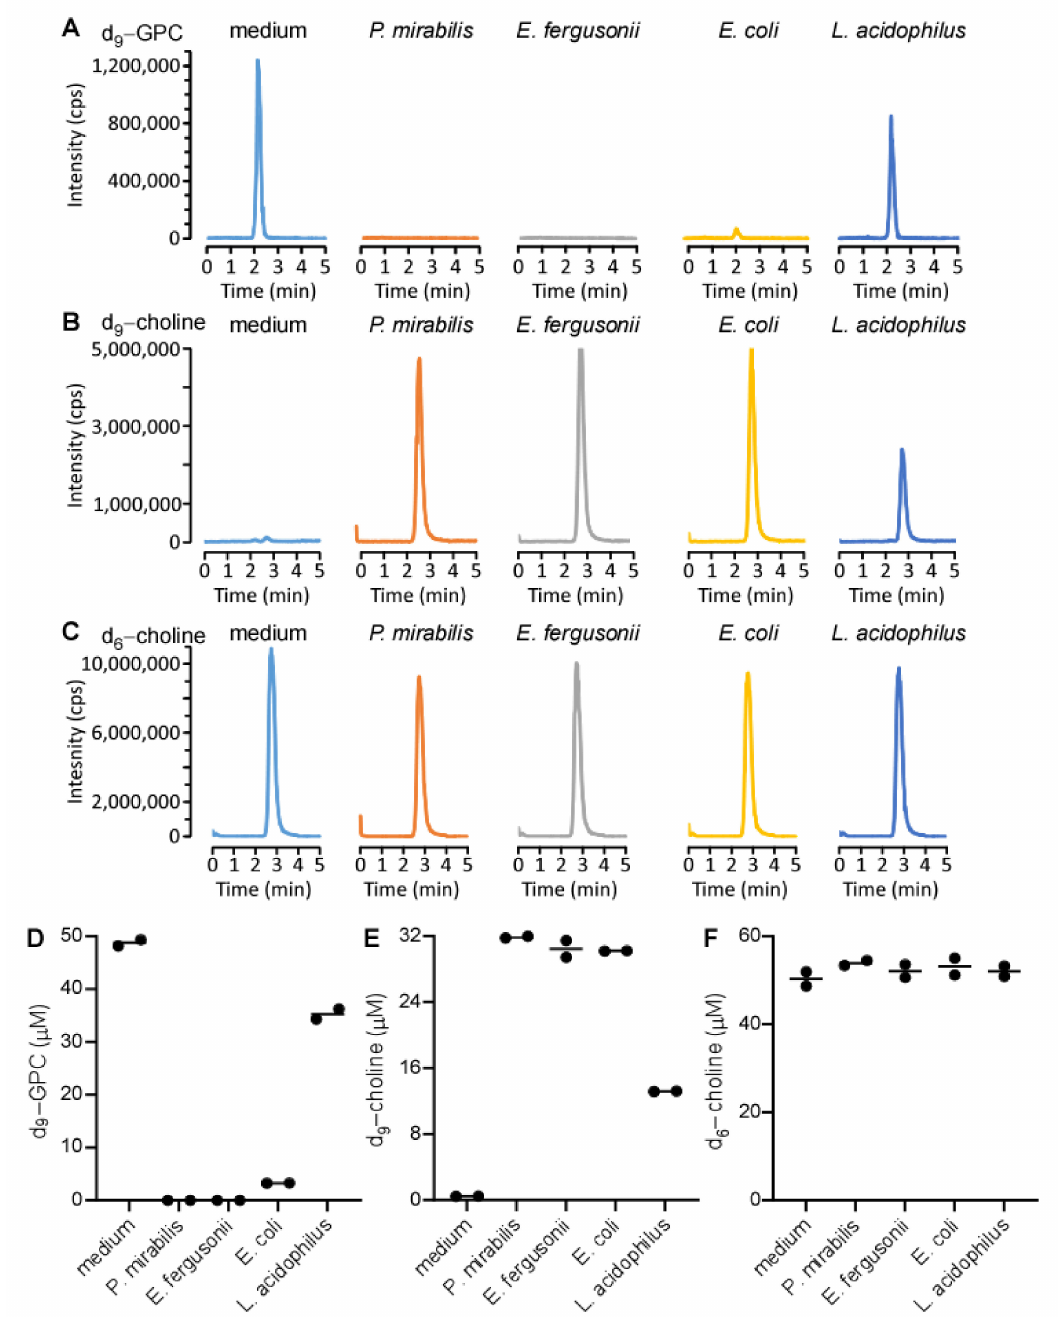
Figure 3. Monitoring product formation after bacterial incubation with deuterated substrates. P. mirabilis , E. fergusonii , E. coli Top10, and L. acidophilus were cultured in LB medium overnight. 200 µ L of overnight growth suspension was mixed with 200 µ L 100 µ M d 9 -GPC and d 6 -choline. After 10 min of incubation at 37 ◦ C, bacterial suspensions were filtered through a 3K cutoff membrane, and the filtrate was mixed with d 4 -choline as internal standard to determine the concentrations of d 9 - GPC, d 9 -choline, and d 6 -choline. ( A – C ) Ion extracted LC chromatograms in positive-ion multiple reaction monitoring mode with parent to daughter transitions of 267 → 125, 113 → 69, and 110 → 66, corresponding to d 9 -GPC ( A ), d 9 -choline ( B ), and d6-choline ( C ), respectively. ( D – F ) concentrations of d 9 -GPC, d 9 -choline, and d 6 -choline, respectively, calculated after bacterial incubation. Each dot in panels ( D – F ) denote an independent experiment